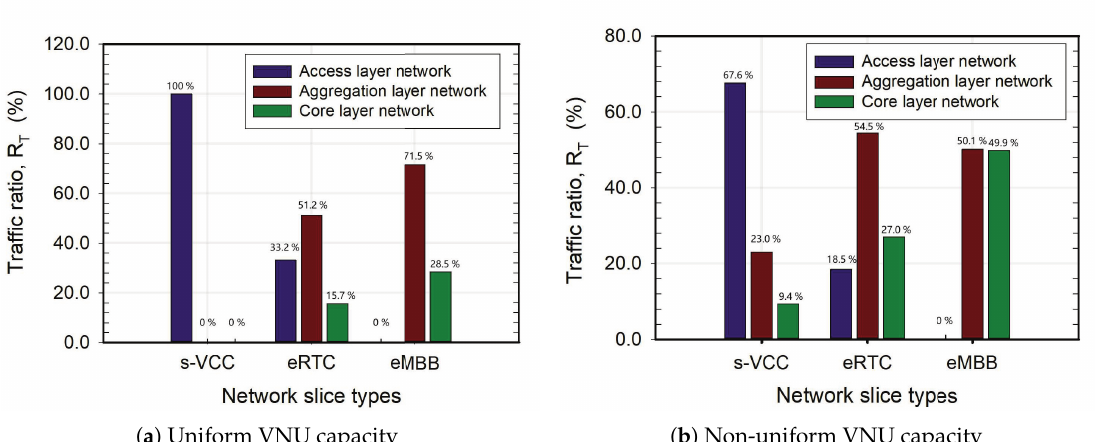
Figure 7. Transport network traffic distribution when the VNU capacity of DCs is uniform and